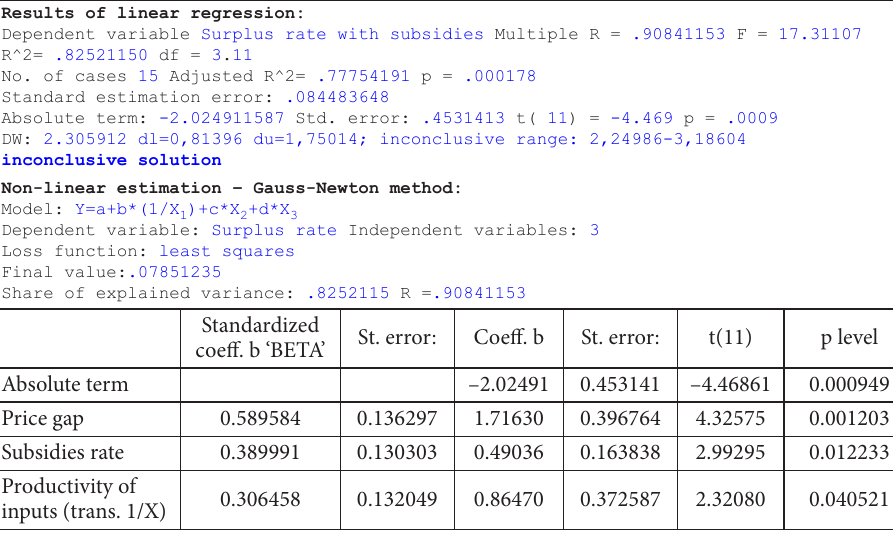
Table 5. Estimation of model 3